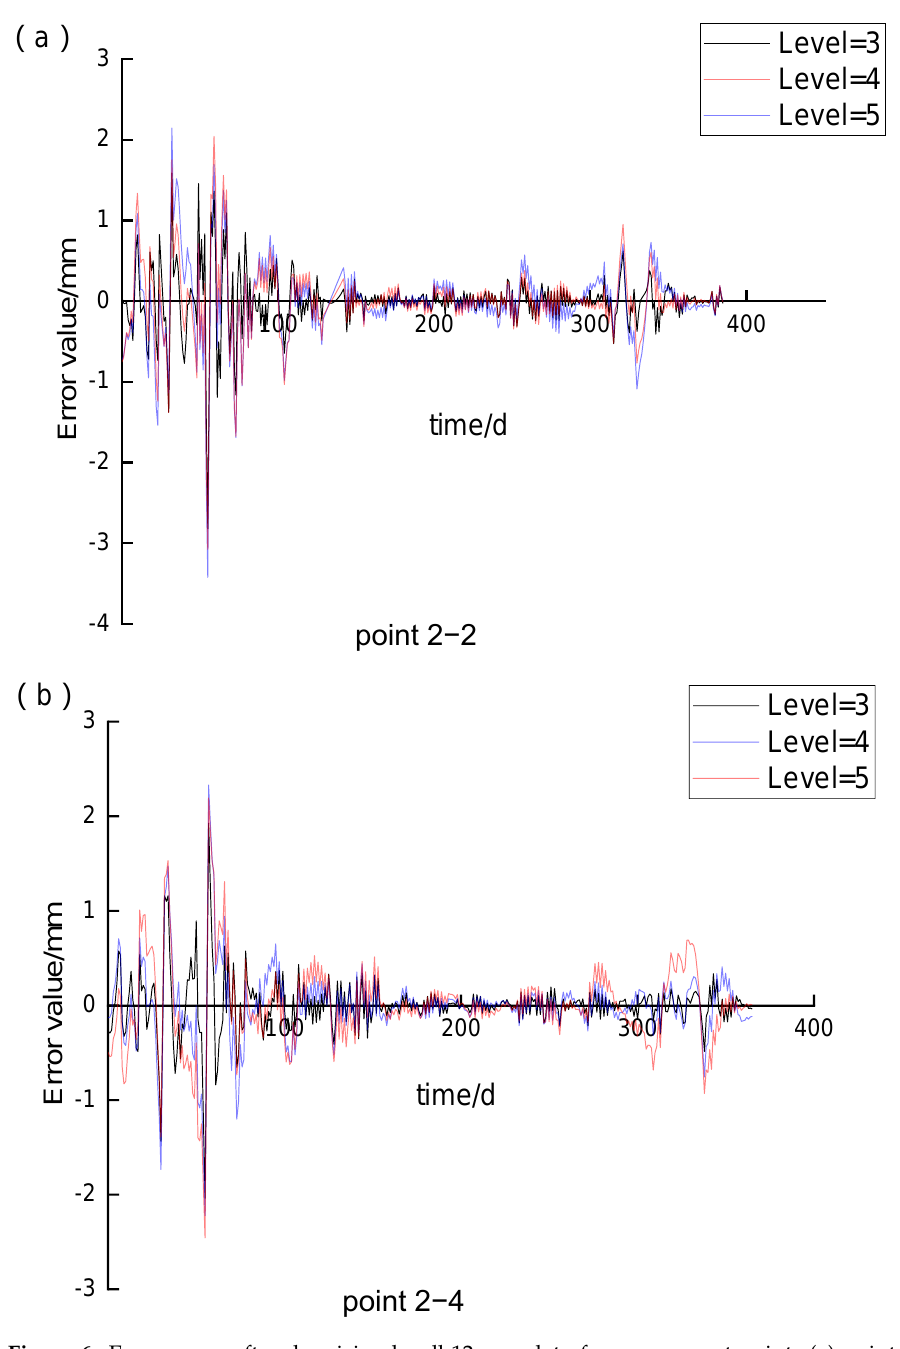
Figure 6. Error curve after denoising by db12 wavelet of measurement points ( a ) point 2 − 2 and ( b ) point 2 − 4 .